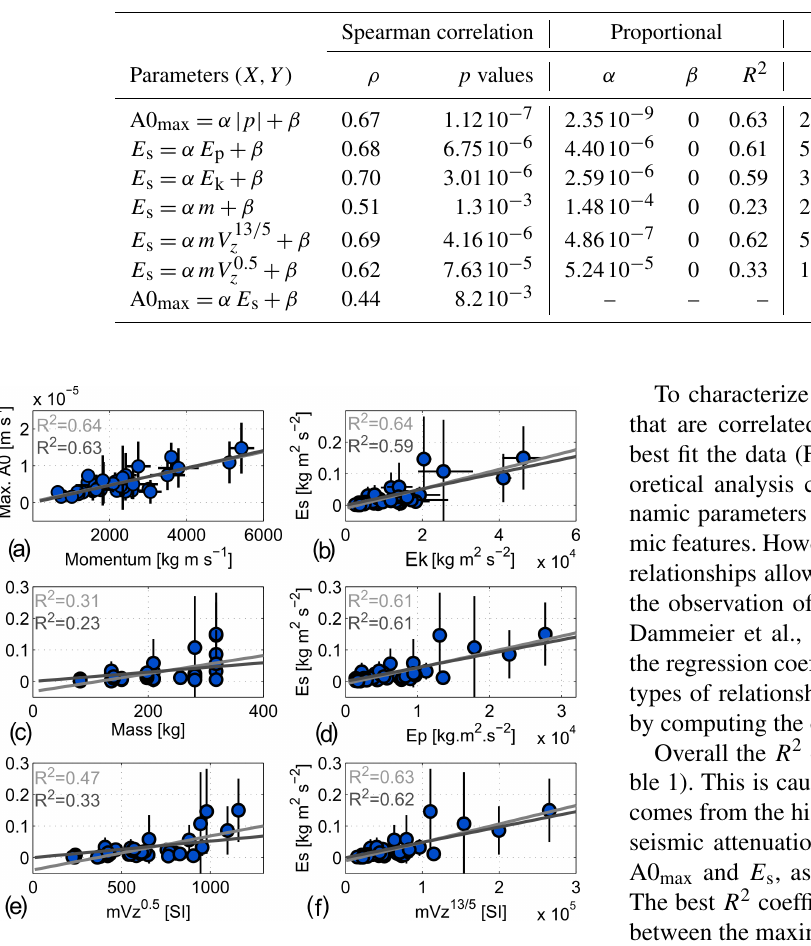
Figure 4. (a) Maximum of the amplitude A0 max , corrected from at- tenuation, as a function of the average momentum | p | of the block before the impact. Radiated seismic energy E s of the seismic sig- nal generated at the impact as a function of (b) the kinetic energy before the impact E k , (c) the masses m of the blocks, (d) the poten- tial energy lost E p , (e) the parameter mV 0 . 5 z , and (f) the parameter mV 13 / 5 z . Errors bars resulting from the computation of the momen- tum, the kinetic energy and the amplitude at the source are indicated by black lines. For each pair of parameters the light-grey line corre- sponds to the best regression line computed for a linear relationship and the dark-grey one to the best regression line computed for a proportional